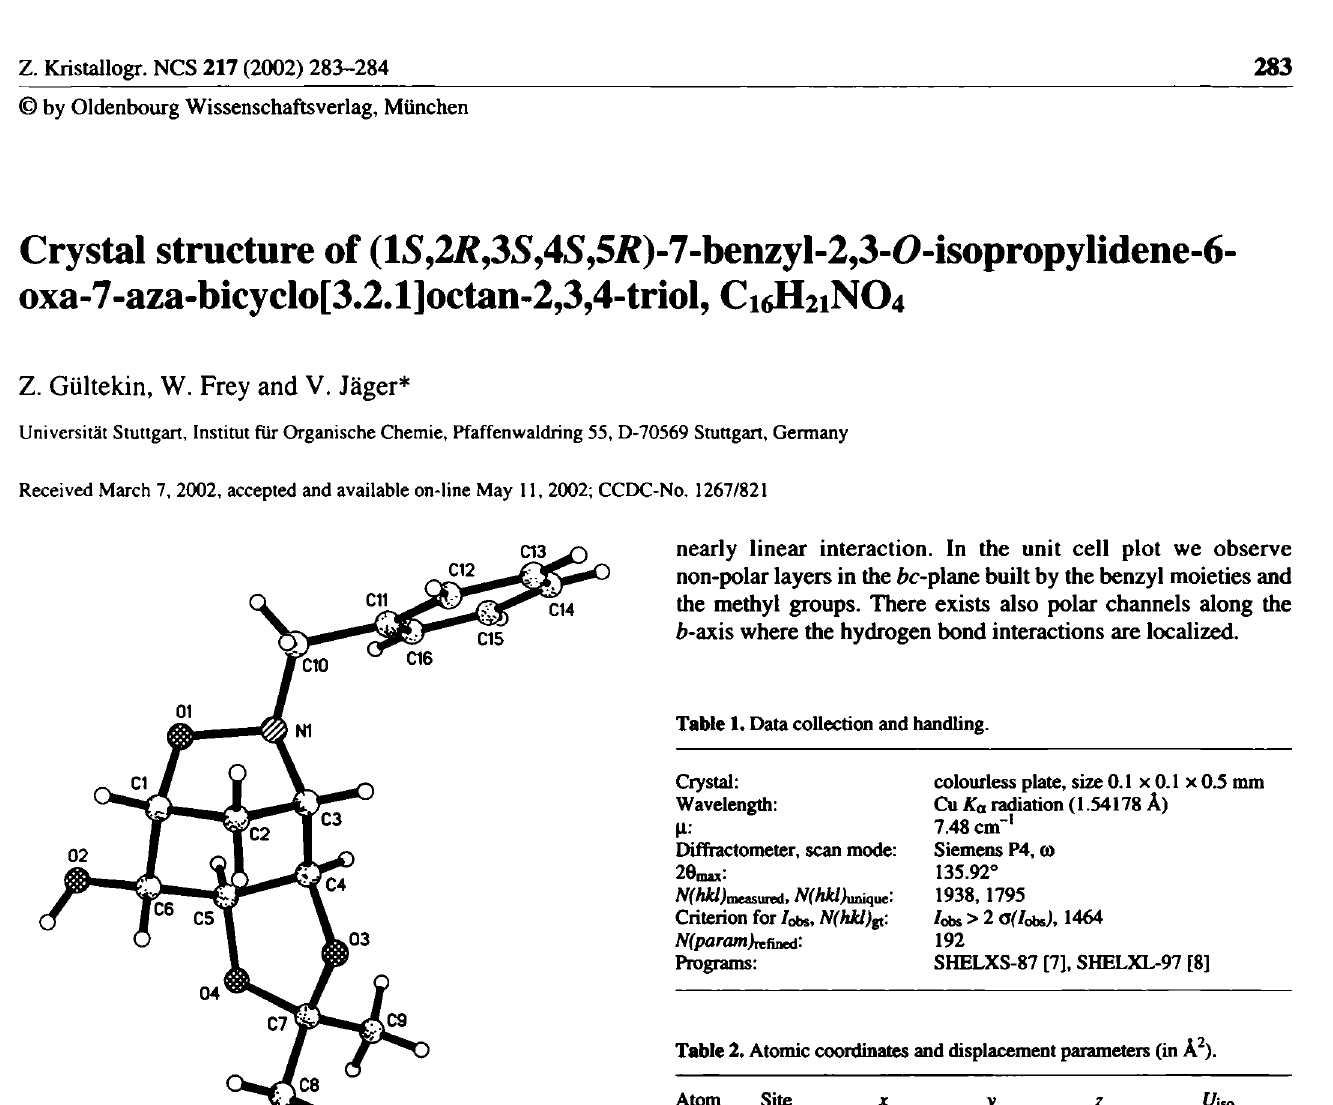
Table 2. Atomic coordinates and displacement parameters (in Â 2